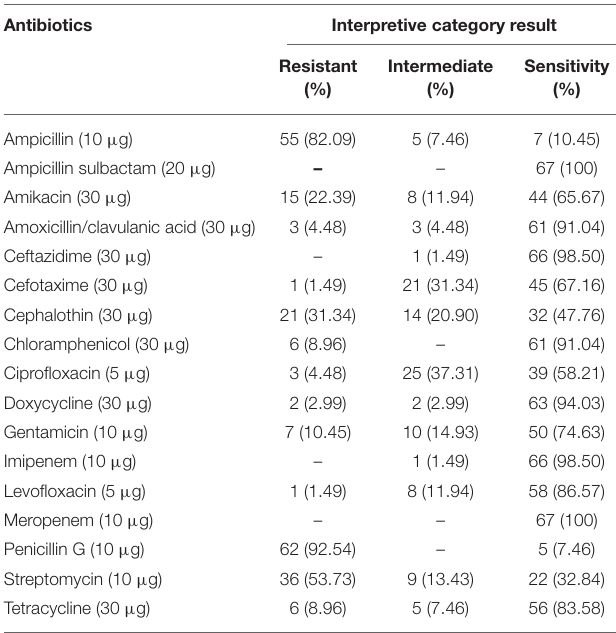
TABLE 4 | Antibiotic susceptibility profiles of V. parahaemolyticus isolated from short mackerels by disc diffusion